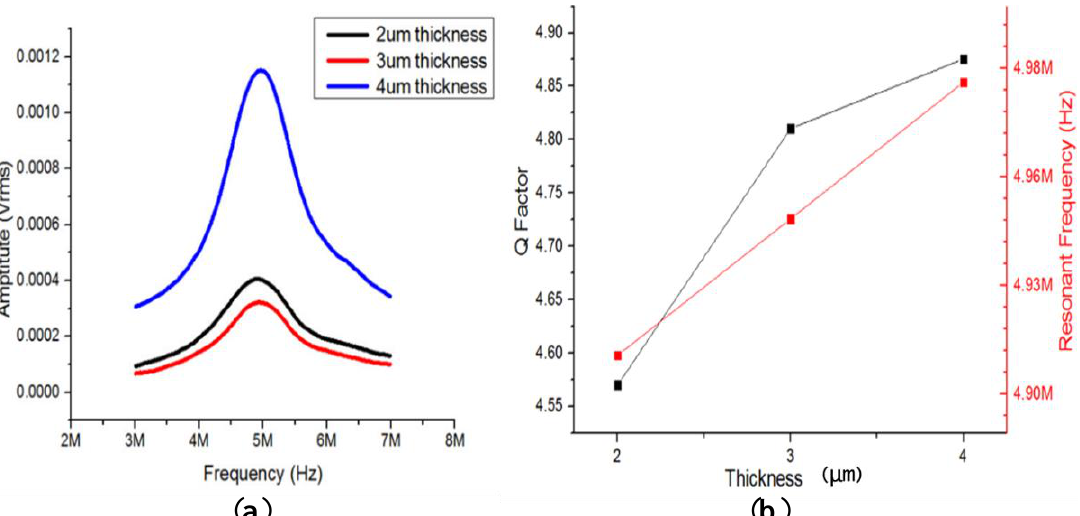
Figure 9. ( a ) Influence of the thickness of the ZnO piezoelectric film on the Q value of the transducer; ( b ) influence of the thickness of the ZnO piezoelectric film on the resonant frequency of the trans- ducer.